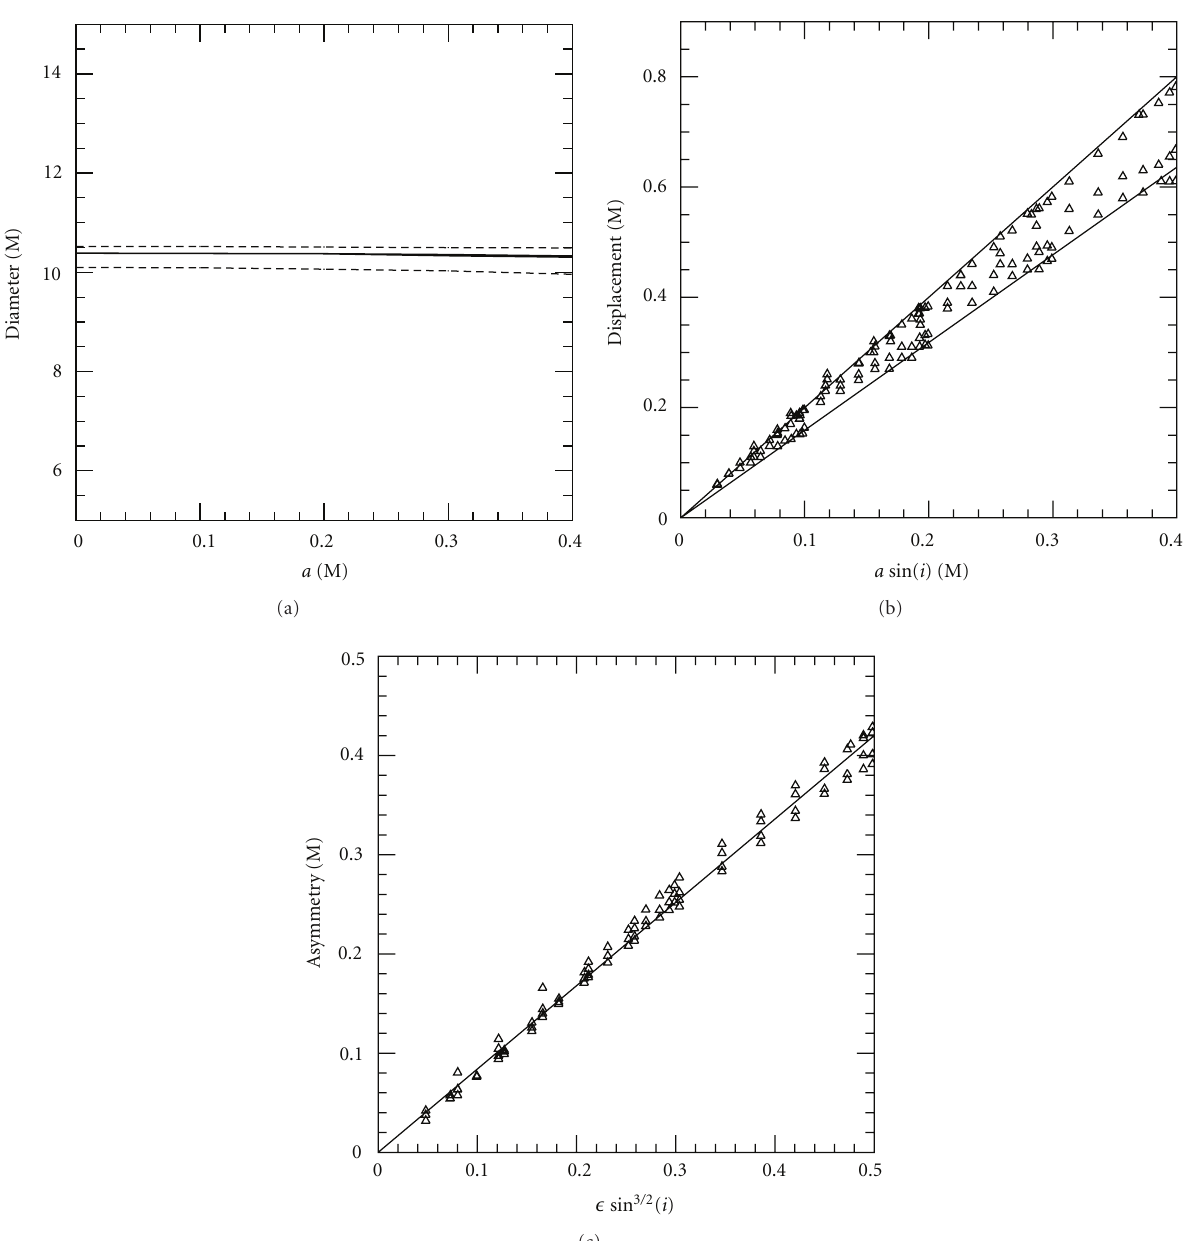
Figure 5: (a) The ring diameter versus spin for inclinations 17 ◦ ≤ i ≤ 86 ◦ for a Kerr black hole (solid lines) and for a quasi-Kerr black hole with a value of the deviation parameter (cid:2) = 0 . 5 (dashed lines). The diameter is practically independent of the spin, inclination, and deviation parameter with a constant value of (cid:6) 10 . 4M for a Kerr black hole. (b) The displacement of the ring of light as a function of a sin i for various values of the parameter 0 ≤ (cid:2) ≤ 0 . 5. The displacement depends only weakly on the parameter (cid:2) . (c) The ring asymmetry versus (cid:2) sin 3 / 2 i for various inclinations 17 ◦ ≤ i ≤ 86 ◦ and 0 . 0 ≤ a/ M ≤ 0 . 4. The asymmetry is nearly independent of the spin and hence provides a direct measure of a violation of the no-hair theorem